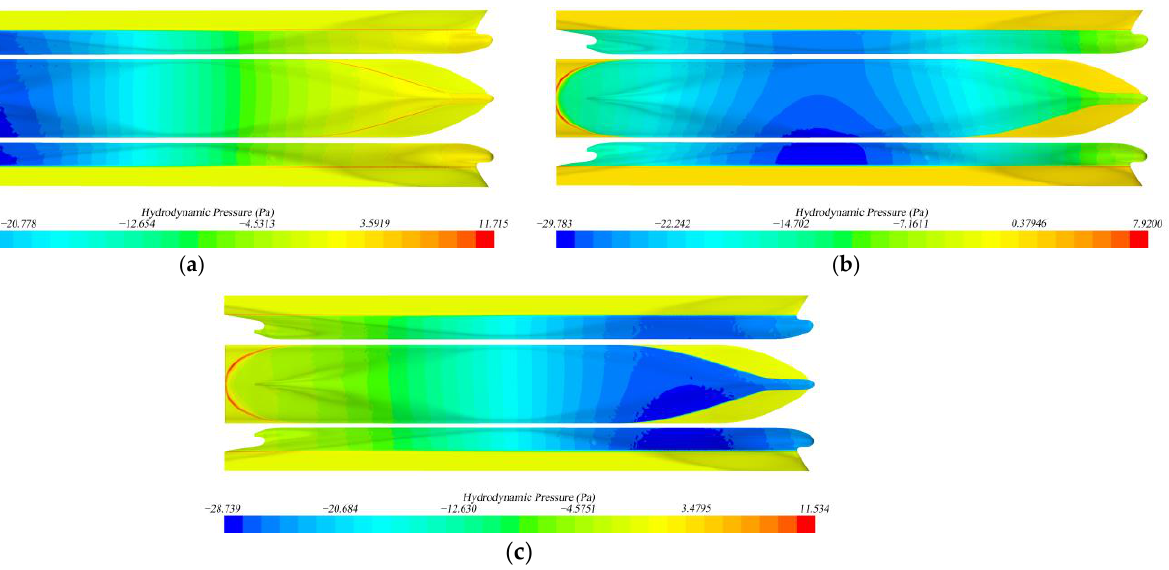
Figure 16. Pressure distributions on the moored ship affected by the primary wave system. ( a ) Pri- mary wave trough passing the stern, ( b ) Primary wave trough passing the midship, ( c ) Primary wave trough passing the bow.